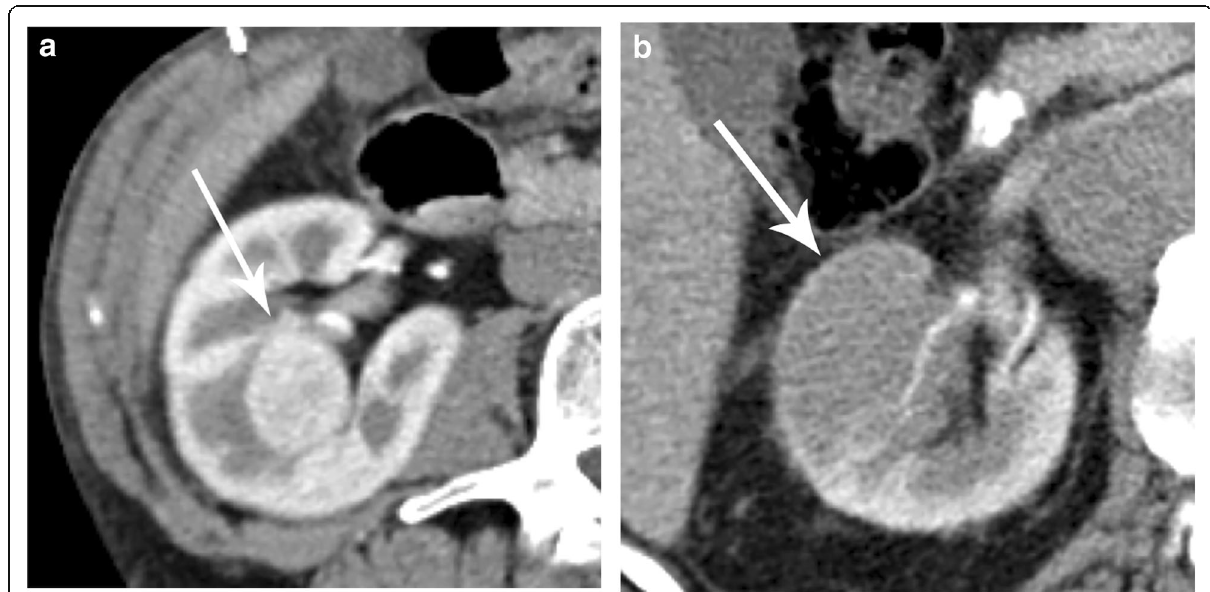
Fig. 6 Solid renal masses in two elderly patients with regular and irregular borders. a Axial contrast-enhanced CT in the arterial phase shows a hyperdense right renal mass with smooth margins and regular shape (arrow) which, if indicated, can be managed with active surveillance. b Axial contrast-enhanced CT scan in the nephrographic phase depicting a hypodense renal mass with irregular borders (arrow). Active surveillance is not indicated in this case